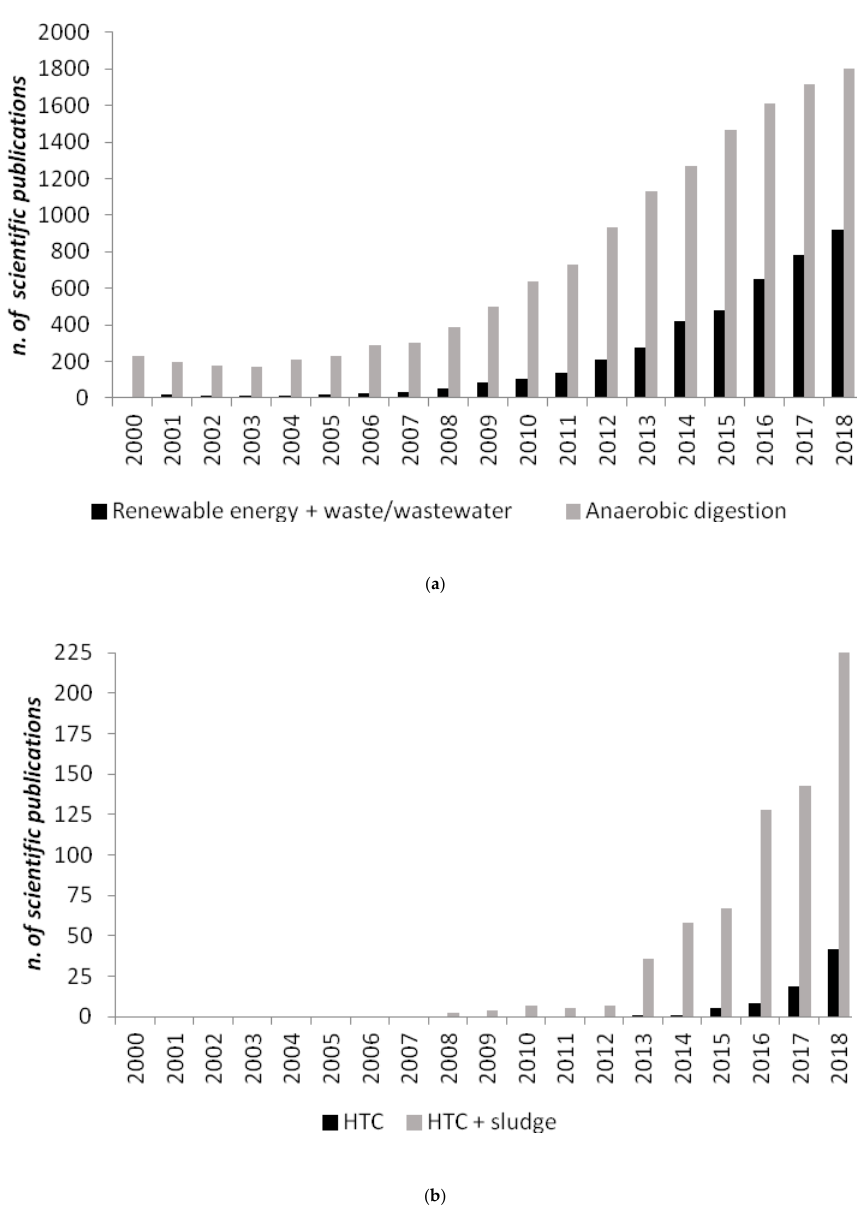
Figure 1. Number of scientific publications containing as keywords: ( a ) “renewable energy and waste/wastewater” and “anaerobic digestion”; ( b ) “hydrothermal carbonization (HTC)” and “hydrothermal carbonization (HTC) and sludge”, based on the NBCI bibliographic database from 2000 to 2018 [1].